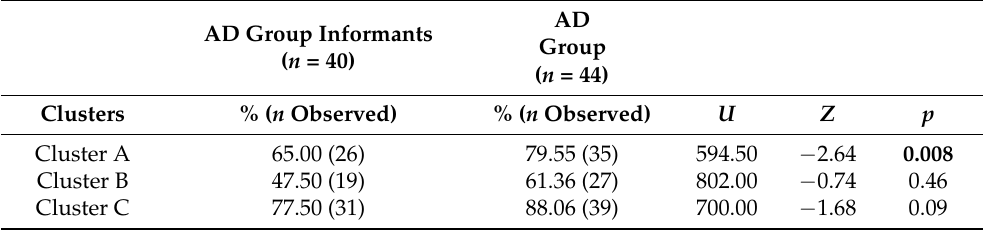
Table 2. Results of the Wilcoxon-Mann–Whitney Test between the AD Group Informants and the AD Group on the Incidence of Clusters of the